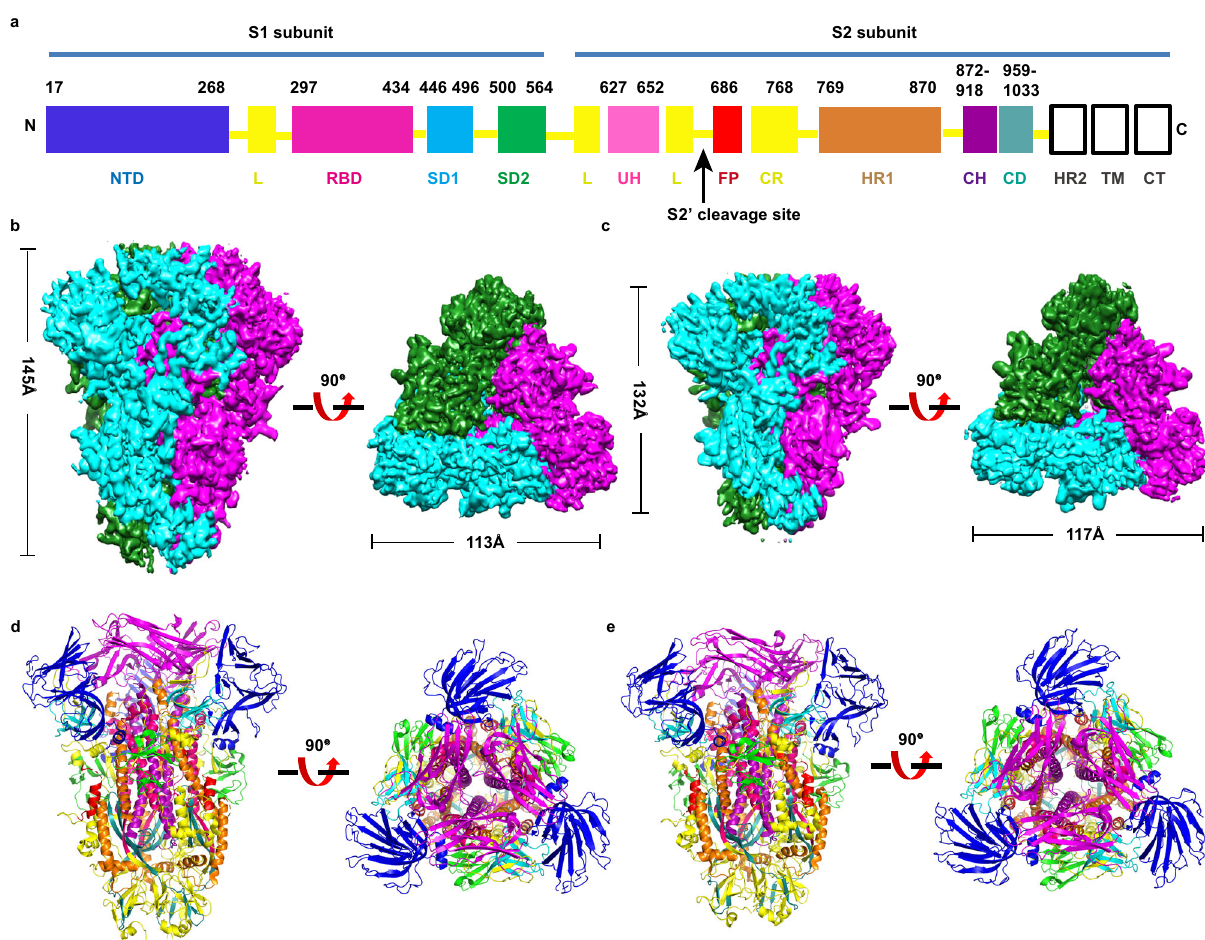
Fig. 1 Overall structure of the HCoV-229E spike in the prefusion conformation. a Schematic diagram of the HCoV-229E S glycoprotein organization. S1 receptor-binding subunit, S2 membrane fusion subunit, NTD N-terminal domain, blue, L linker region, yellow, RBD receptor-binding domain, magenta, SD1 subdomain1, cyan, SD2 subdomain2, green, UH upstream helix, pink, FP fusion peptide, red, CR connecting region, yellow, HR1 heptad repeat 1, orange, CH central helix, purple, CD connector domain, aquamarine, HR2 heptad repeat 2, TM transmembrane domain, CT cytoplasmic tail, the range of FP used to make the fi gures is consistent with that of a previous structural study on the MHV spike 18 . The black line boxes denote the regions that are unresolved in the density map (HR2) or not part of the construct (TM and CT). b , c The orthogonal views of the S protein in conformations 1 and 2. The protomer A, B, and C are colored as cyan, magenta, and green, respectively. The length of conformations 1 and 2 is measured via the PyMOL. d , e The atomic structures of conformations 1 and 2 are shown as ribbon diagrams oriented as in ( b ) and ( c ). The domains are indicated and colored as de fi ned in Fig.